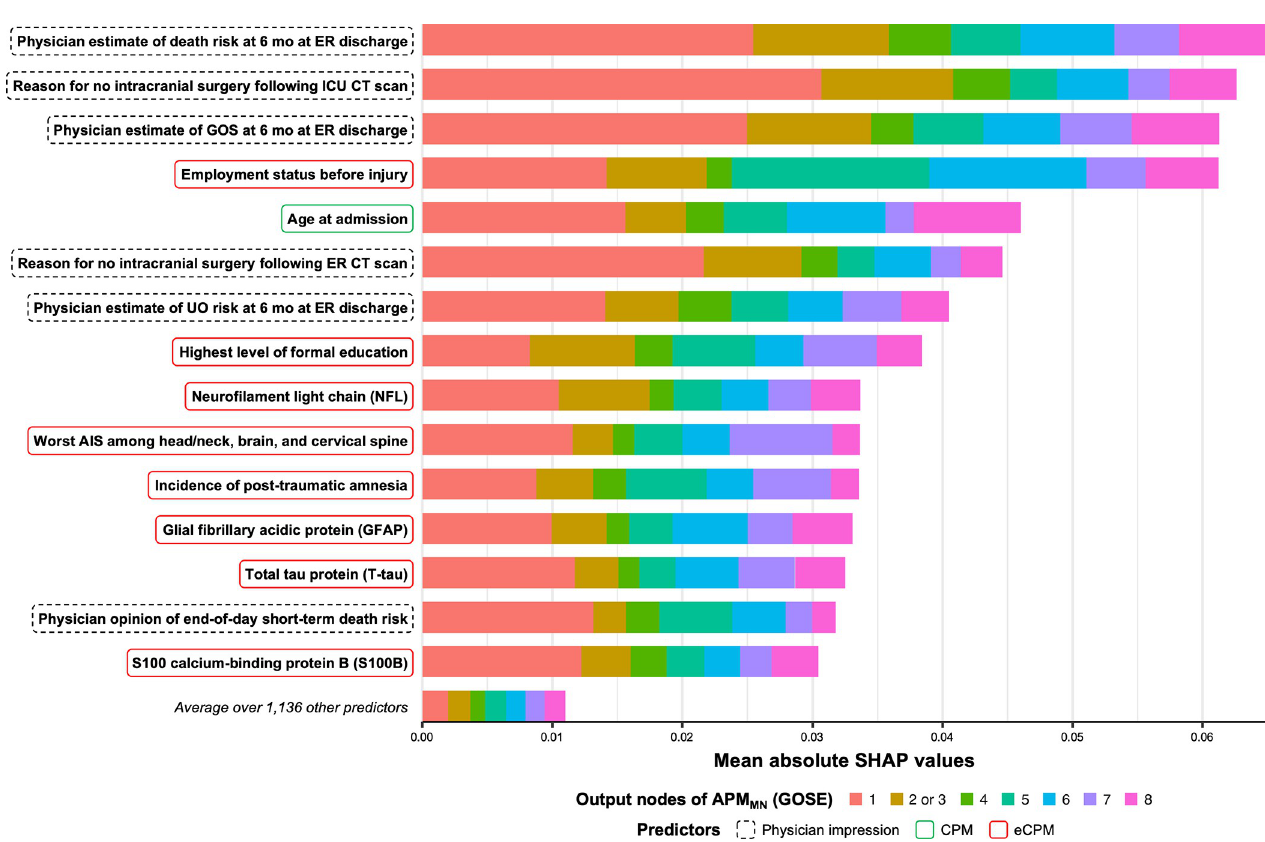
Fig 4. Mean absolute shapley additive explanation (SHAP) values of most important predictors for multinomial-encoding all-predictor-based model (APM MN ). ICU = intensive care unit. ER = emergency room. CT = computerised tomography. GOS = Glasgow Outcome Scale (not extended). UO = unfavourable outcome, defined by functional dependence (i.e., GOSE � 4). AIS = Abbreviated Injury Scale. GOSE = Glasgow Outcome Scale–Extended at 6 months post-injury. CPM = predictors that are included in the original concise predictor set. eCPM = predictors that are added to the original concise predictor set to form the extended concise predictor set. The mean absolute SHAP value is interpreted as the average magnitude of the relative additive contribution of a predictor’s most important token towards the predicted probability at each GOSE score for a single patient. Predictor types are denoted by the coloured boundary around predictor names. Physician impression predictors denote predictors that encode the explicit impressions or rationales of ICU physicians and are not considered for the extended concise predictor